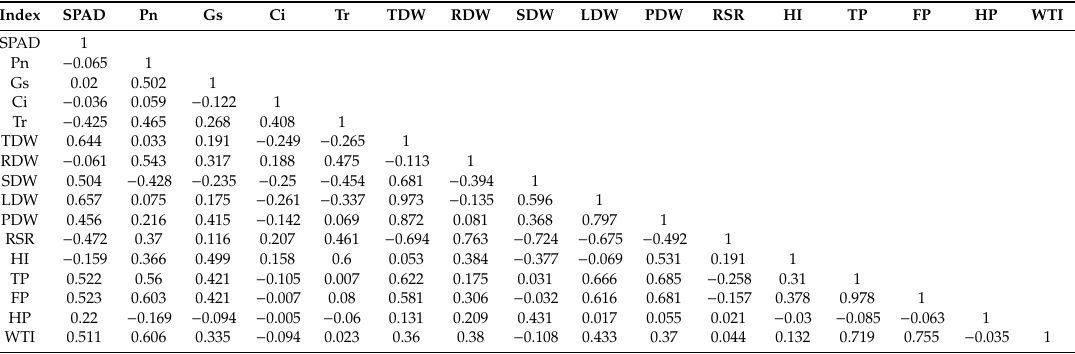
Table 3. Correlation coe ffi cients of the individual indices of peanut under waterlogging stress.